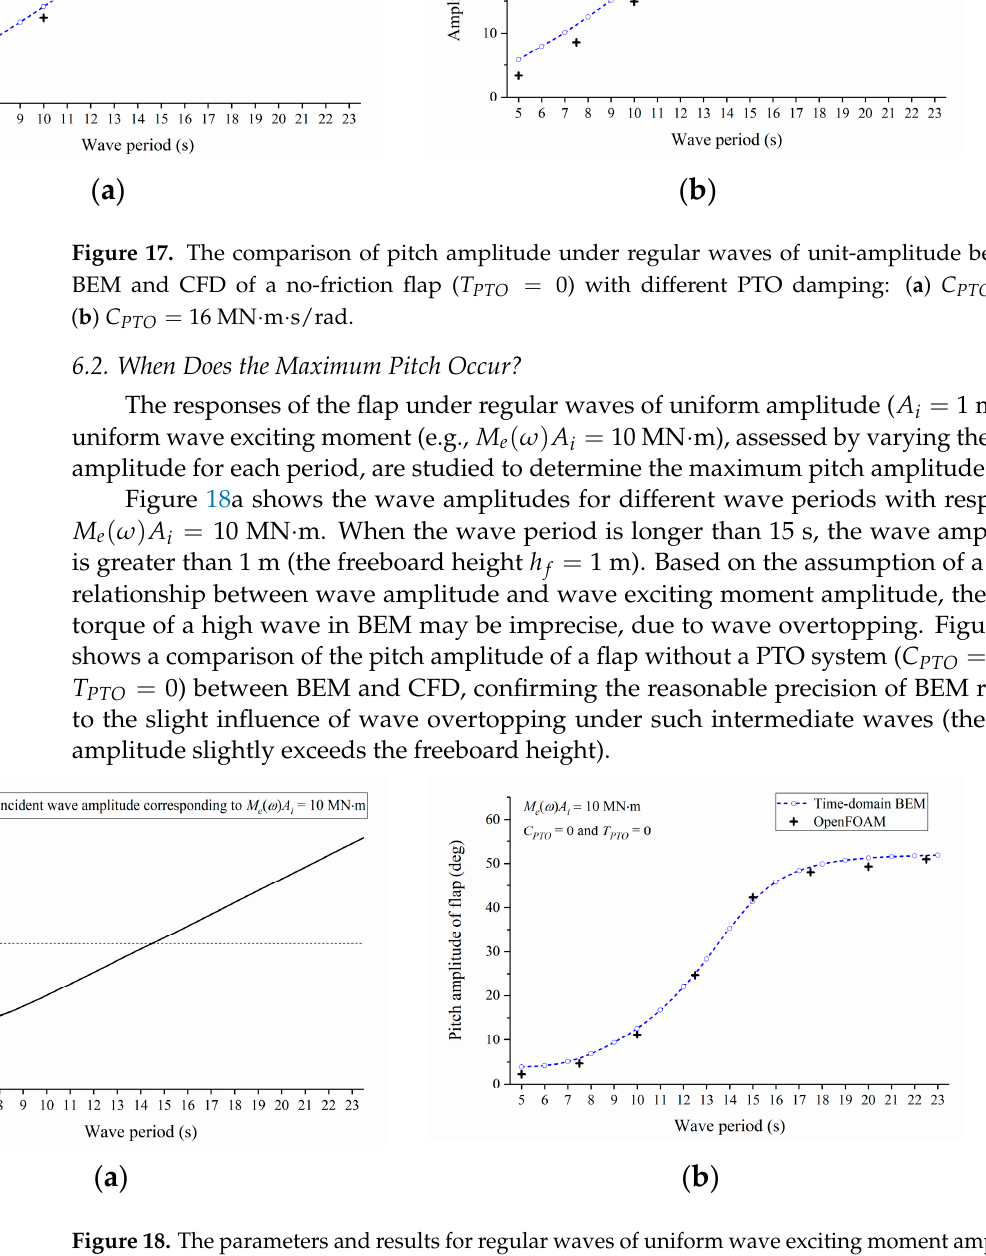
Figure 17. The comparison of pitch amplitude under regular waves of unit-amplitude between BEM and CFD of a no-friction flap ( 𝑇 (cid:3017)(cid:3021)(cid:3016) = 0 ) with different PTO damping: ( a ) 𝐶 (cid:3017)(cid:3021)(cid:3016) = 0 ; ( b ) 𝐶 (cid:3017)(cid:3021)(cid:3016) = 16 MN ∙ m ∙ s/rad .